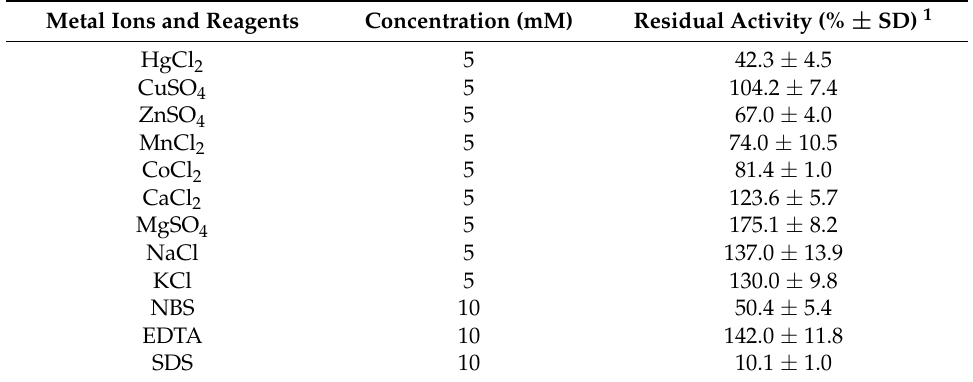
Table 2. Effect of various metal ions and reagents on extracellular lipase activity from M. echinosphaera CBS 575.75. Metal Ions and Reagents Concentration